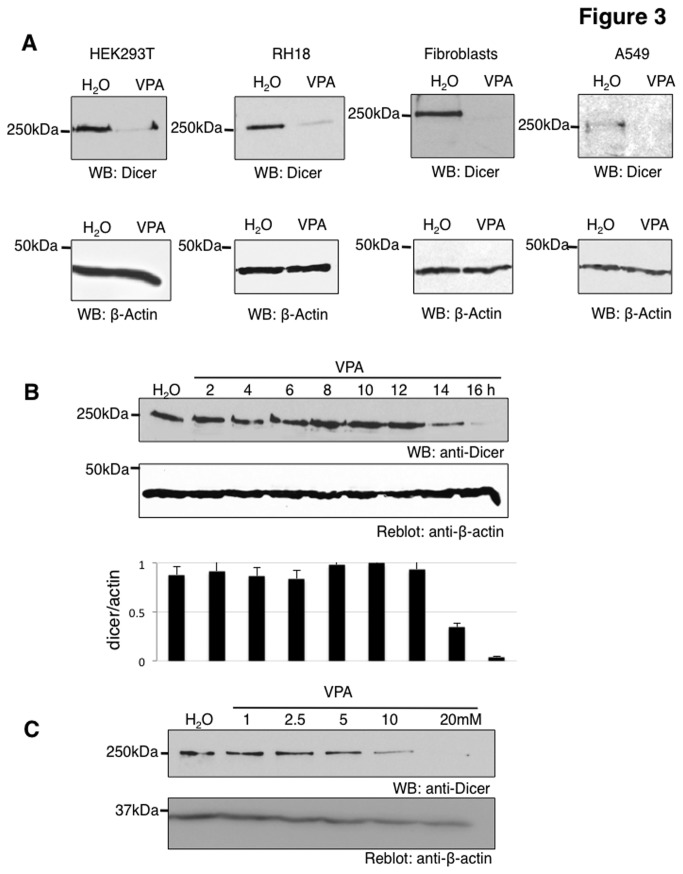
Influence of VPA on DICER protein expression levels.
A. Effect of VPA on DICER protein level in different cell lines. The cell lines indicated were treated with 20 mM VPA for 16 hours and the expression of DICER was detected using Western blot. Beta actin was used as a loading control in each cell line.
B. Time course of DICER expression in HEK293 cells treated with 20 mM VPA. DICER protein level is significantly reduced after 12 hours of VPA treatment. To quantify the effect, we calculated the intensity of DICER protein signal normalized to ß-actin, shown below, n=3.
C. Concentration dependency of DICER degradation in HEK293 cells during 16 hours of treatment.